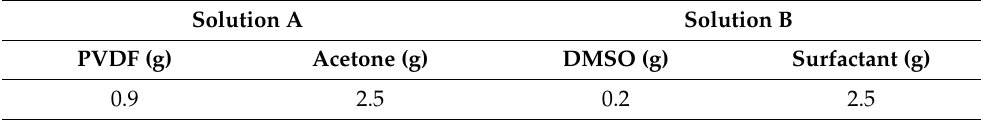
Table 1. Preparation of pure